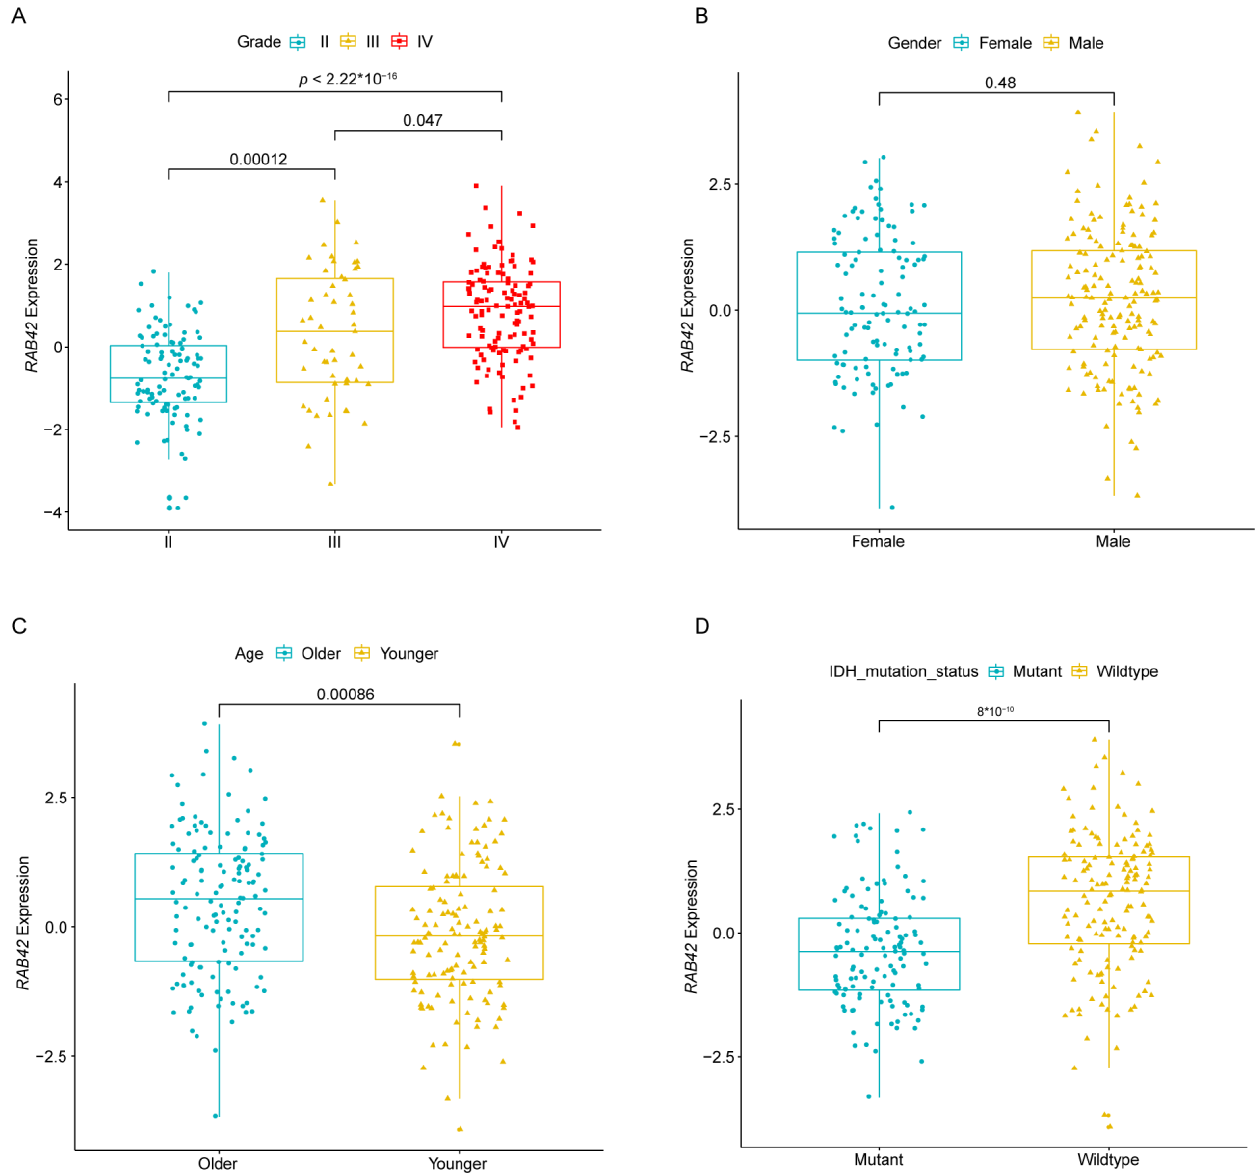
Figure 2. Association of RAB42 with clinicopathological characteristics. ( A – D ) Based on the CGGA dataset, the correlations of RAB42 expression with different grades, genders, ages, and IDH mutation status, separately.